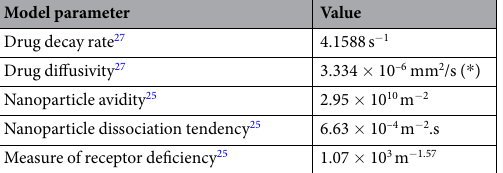
Table 3. Main parameters used in the computational “blackbox” model. ( * ) The value for drug diffusivity was incorrectly reported in Table 1 of 27 as 3.334 × 10 − 3 mm 2 /s, and is corrected here. Both the study in 27 and here used the same default